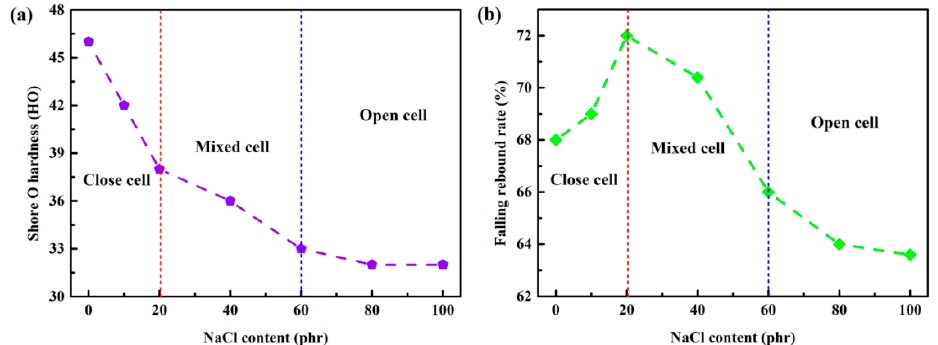
Figure 2. Cell structural properties of silicon rubber foams with different added amounts of NaCl. ( a ) Apparent density and porosity; ( b ) water absorption.